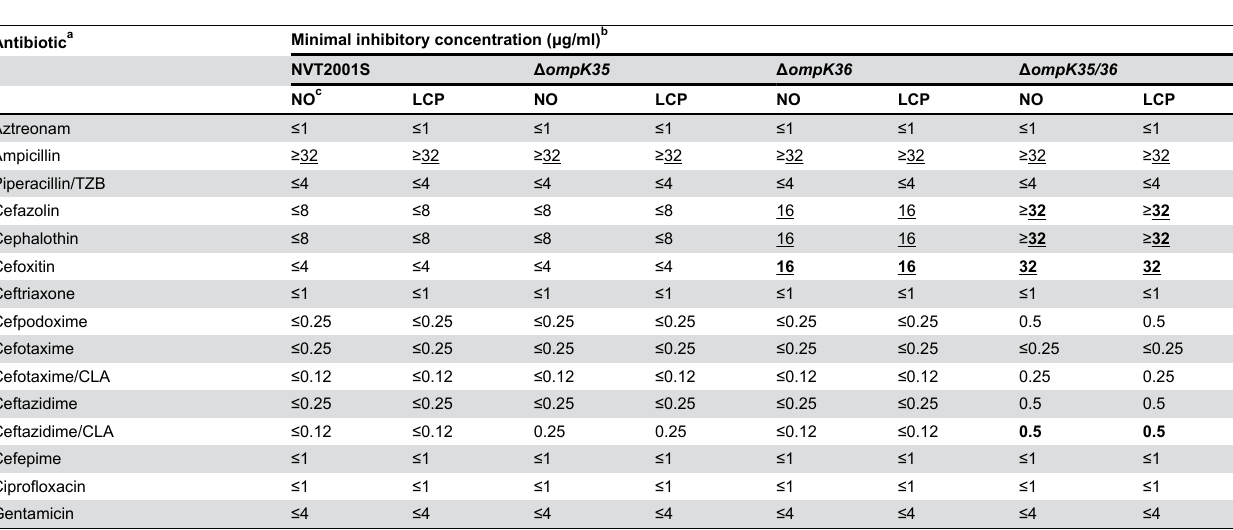
Table 2. MICs of antibiotics against K. pneumoniae NVT2001S and its porin-loss mutants with or without the low-copy- number plasmid